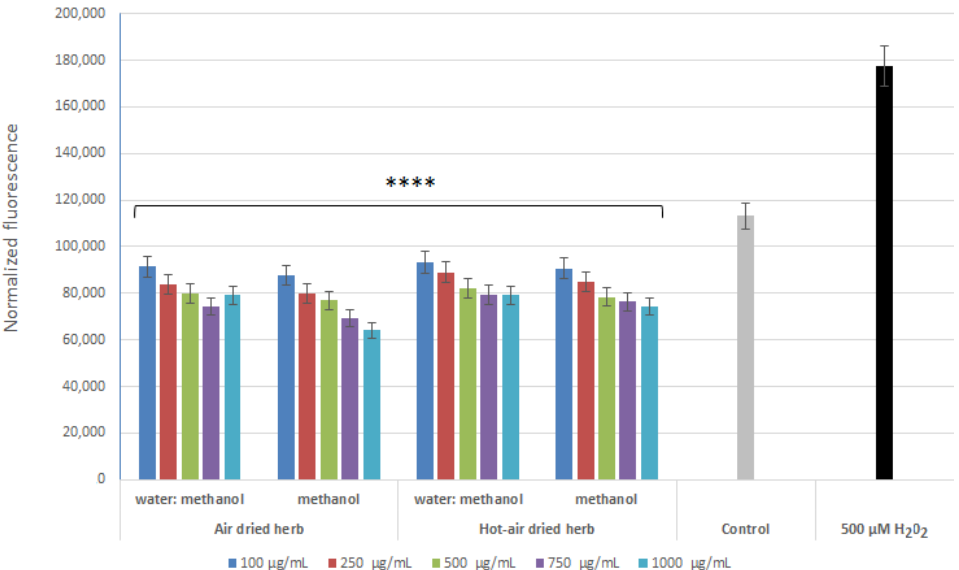
Figure 5. Effect of B. officinalis extracts on DCF fluorescence in BJ cells. Data are the means ± SD of three independent experiments. **** p < 0.0001 versus the control.